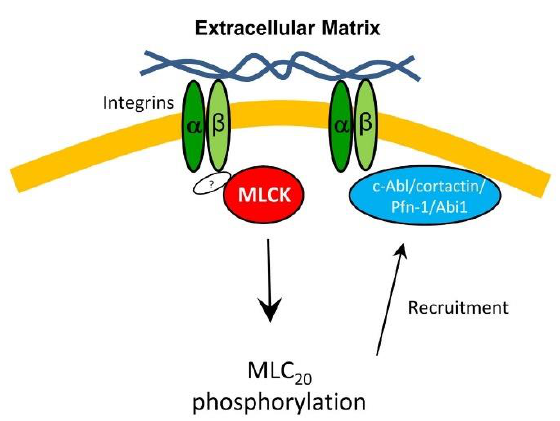
Figure 7. Proposed mechanism: In response to extracellular cues (e.g., the ECM), integrin β 1 locates at the tip of lamellipodia, which recruits MLCK to the leading cell edge via an unknown mechanism. The kinase then catalyzes MLC 20 phosphorylation, which promotes the recruitment of c-Abl, cortactin, Pfn-1, and Abi1 to the leading edge, lamellipodial formation, and migration. Supplementary Materials: The following are available online at https://www.mdpi.com/article/10.3390/cells11152334/s1, Figure S1: Interaction of integrin β 1 with MLCK. Input and MLCK immunoprecipitates of human airway smooth muscle cells were assessed by immunoblotting. Integrin β 1 is found in MLCK immunoprecipitates. Blots are representative of three identical